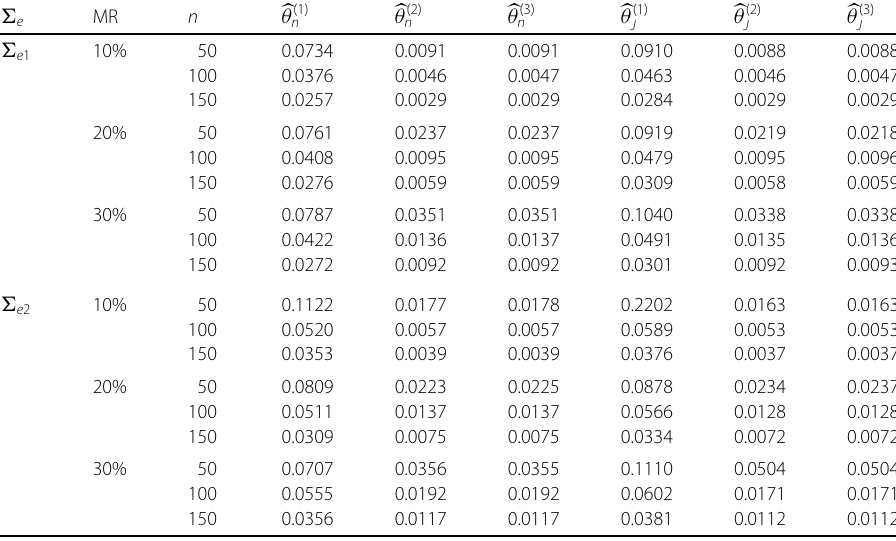
(cid:16) θ ( k ) (cid:16) θ ( k ) with different sample sizes and n and J